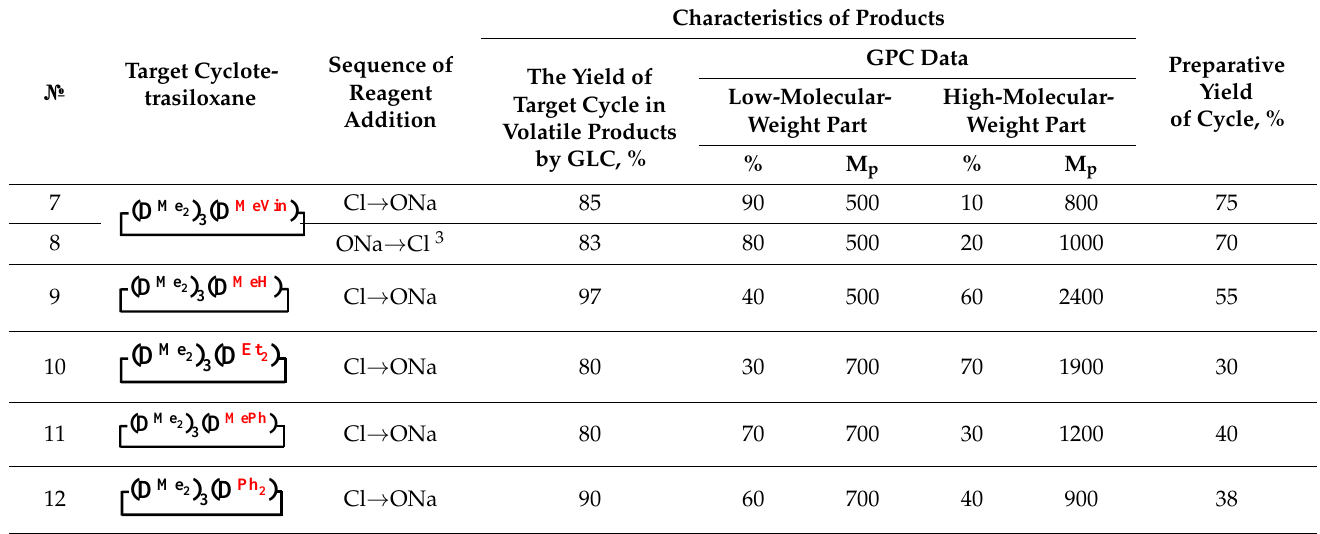
Table 2. Reaction conditions in MTBE and product characteristics.